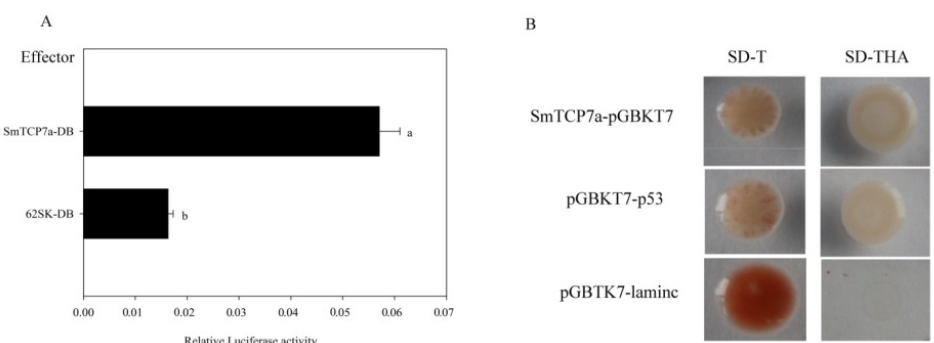
Figure 3. Analysis of SmTCP7a transactivation functions. ( A ) Transactivation of GAL4 response transcription by SmTCP7a fused to the DNA-binding domain of GAL4 in N. benthamiana leaves. Different letters indicate statistically significant difference (independent-sample t -test (confidence interval = 95%), n = 3, α = 0.05). The data were analyzed by the SPSS17 software. ( B ) Transactivation by SmTCP7a in a yeast one-hybrid.